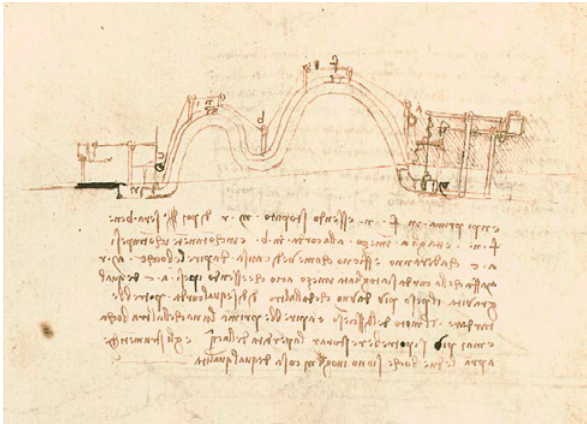
Figure 19. C.A., fol. 126r, detail: double